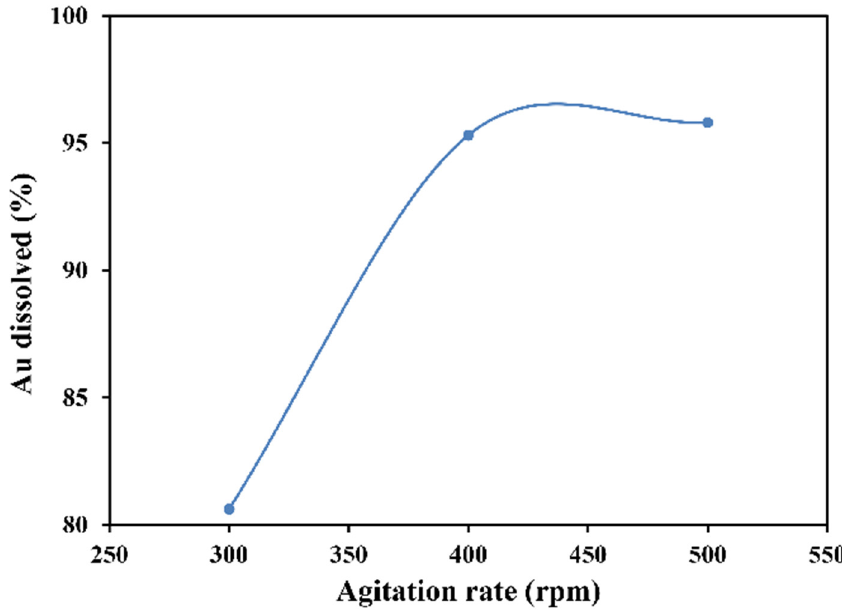
Figure 10. Diagram of Au dissolved % vs. agitation rate rpm.